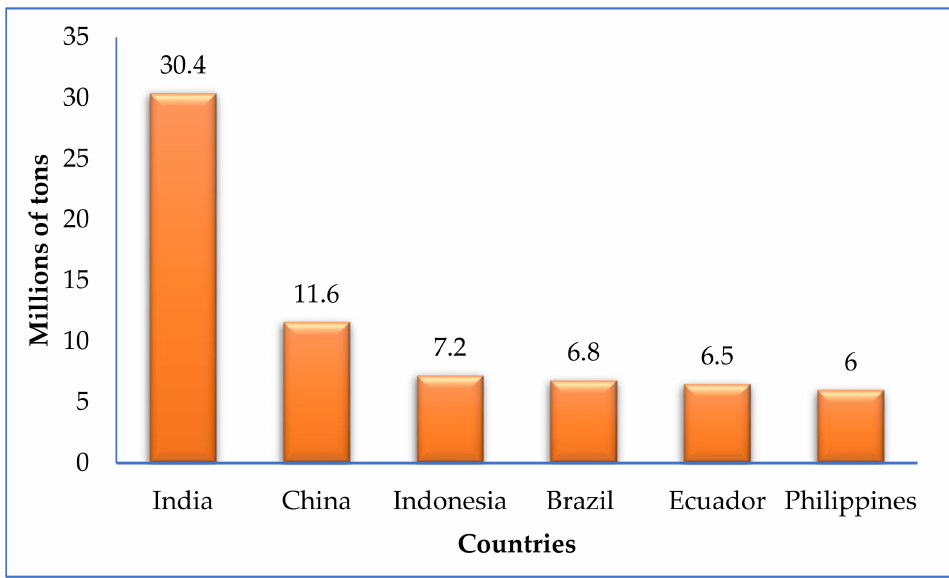
Figure 2. World banana production in 2019